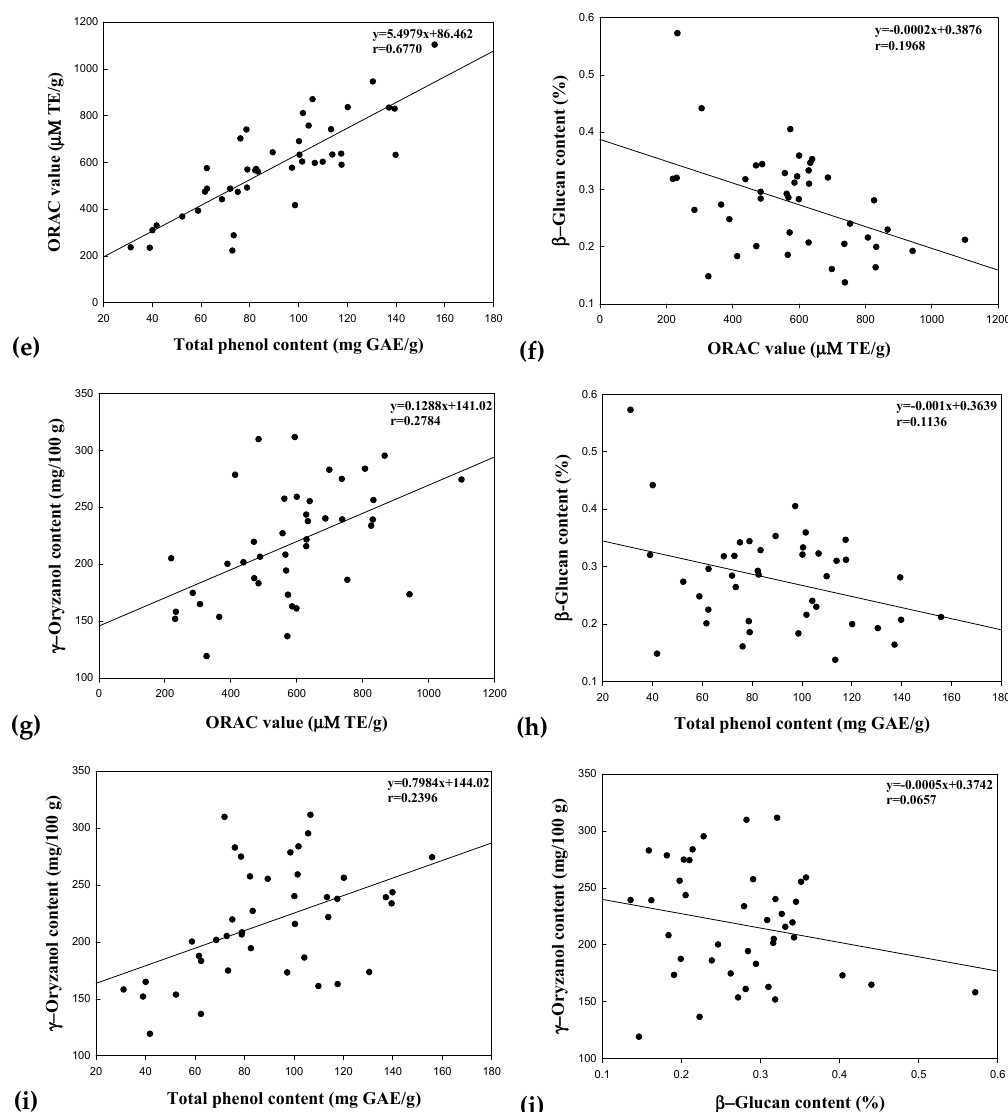
Figure 3. Linear correlation between the antioxidant activities and bioactive compounds. DPPH radical scavenging activity and the ORAC value ( a ); DPPH radical scavenging activity and the total phenolic content ( b ); DPPH radical scavenging activity and the β -glucan content ( c ); DPPH radical scavenging activity and the γ -oryzanol content ( d ); ORAC value and total phenolic content ( e ); ORAC value and the β -glucan content ( f ); ORAC value and the γ -oryzanol content ( g ); total phenolic content and the β -glucan content ( h ); total phenolic content and the γ -oryzanol content ( i ); and β -glucan content and the γ -oryzanol content ( j ). All of correlations among the response variables were significant as p < 0.05.